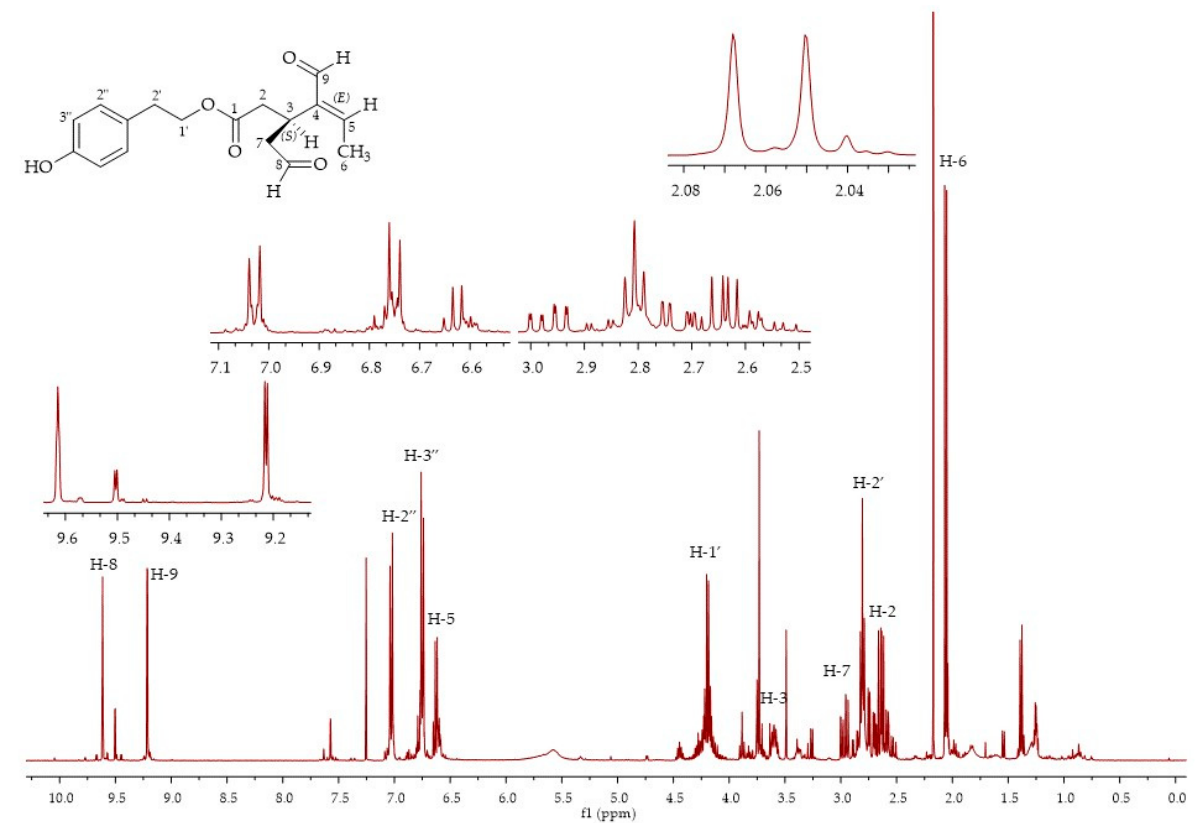
Figure 6. 1 HNMR spectra of fraction 3, oleocanthal (3 S ,4 E )- 9 .